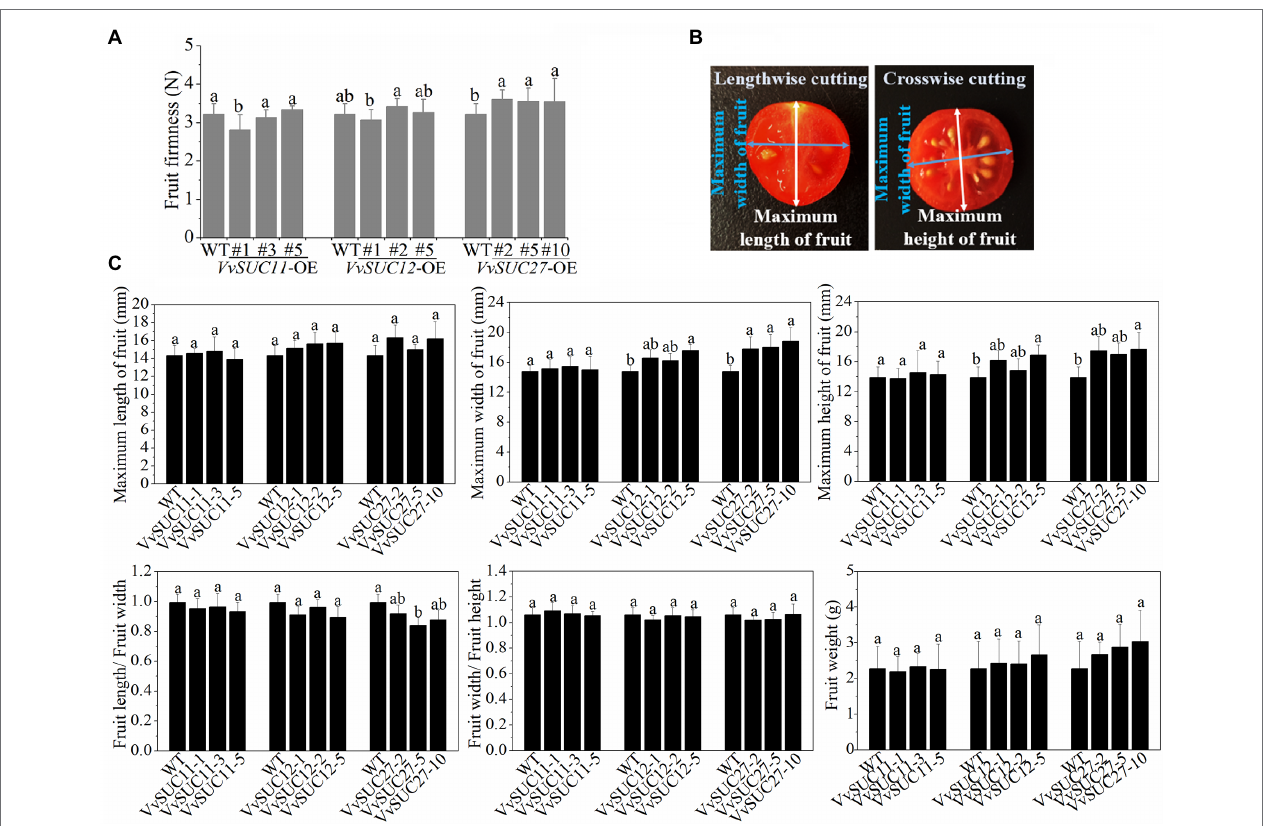
FIGURE 3 | Phenotype, firmness, and weight of VvSUC -OE tomato fruits. (A) Comparison between the WT and each VvSUC -OE line regarding fruit firmness. (B) Diagram of the maximum length, width, and height of fruits. (C) The maximum length, width, height, length/width ratio, width/length ratio, and fruit weight of WT and VvSUC- OE tomato fruit. Error bars indicate the mean ± SD of twenty biological replicates. Different lowercase letters show statistically significant differences between the WT and each VvSUC -OE line (Tukey’s test, p <